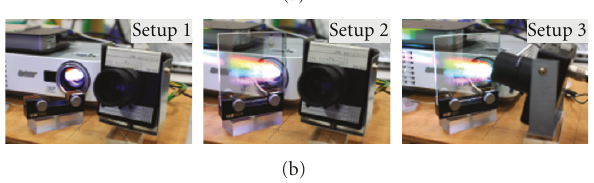
Figure 5: (a) Luminance values seen by the camera at di ff erent distances to the surface in three di ff erent setups. Note that the maximum possible luminance here is 255. (b) The three setups used in the